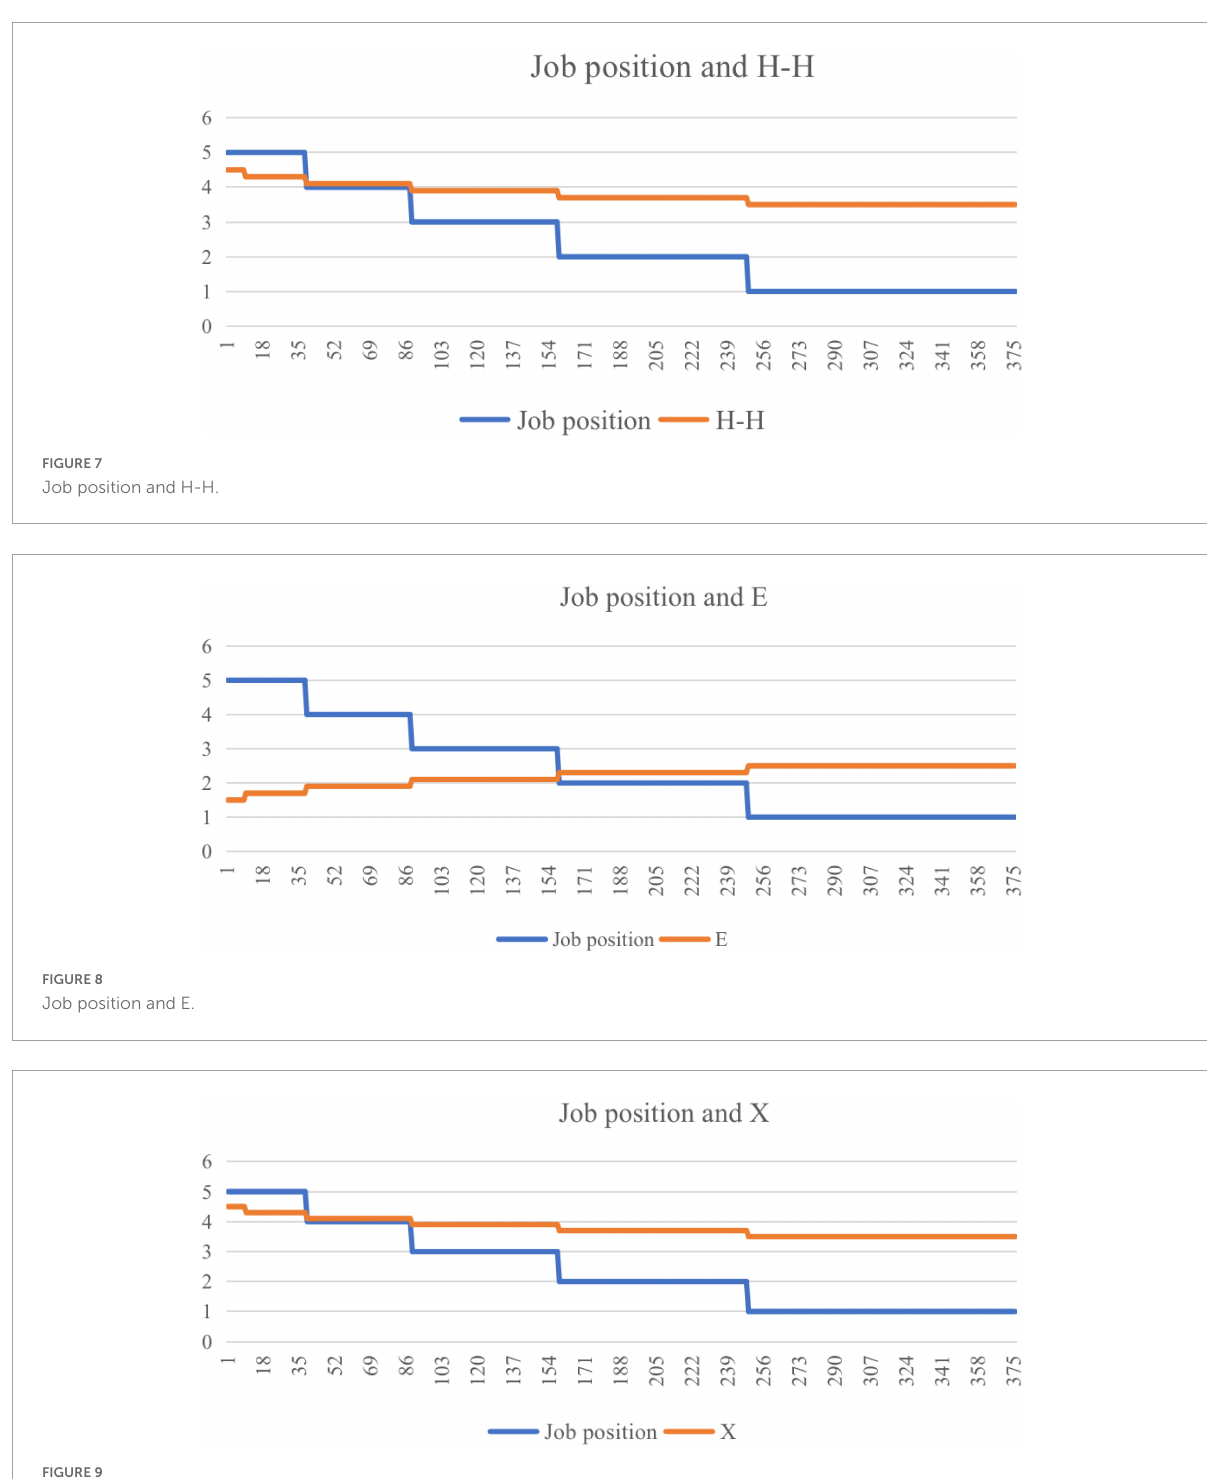
FIGURE9 Job position and